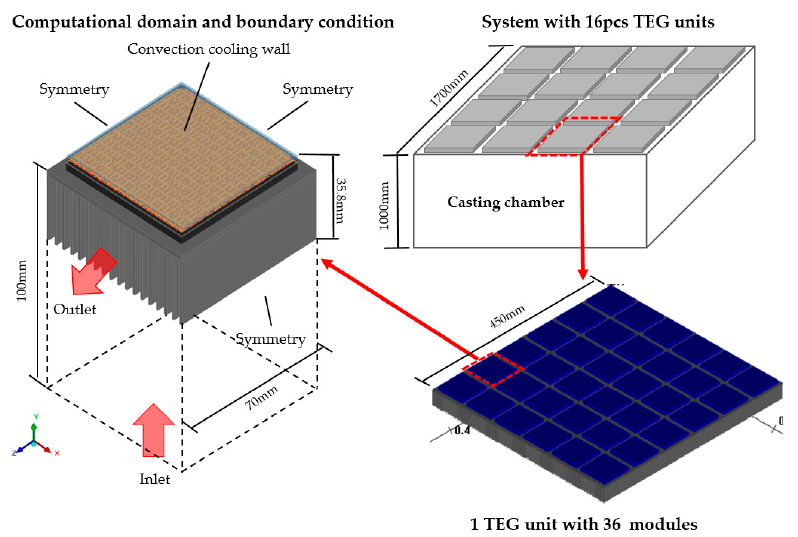
Figure 3. Simplified computational domain and boundary conditions.